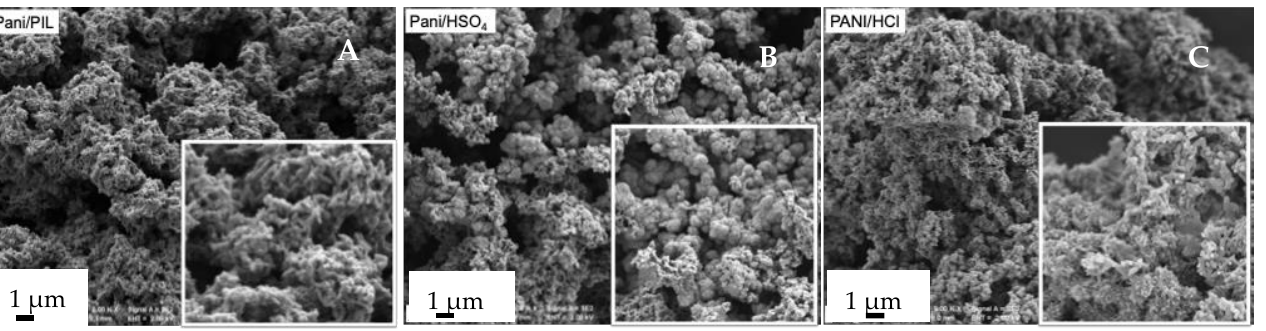
1 µm 1 µm 1 µm Figure 1. SEM images of PANI/PIL ( A ), PANI/HSO 4 ( B ) and PANI/HCl ( C Figure 1. SEM images of PANI/PIL ( a ), PANI/HSO 4 ( b ) and PANI/HCl ( c )